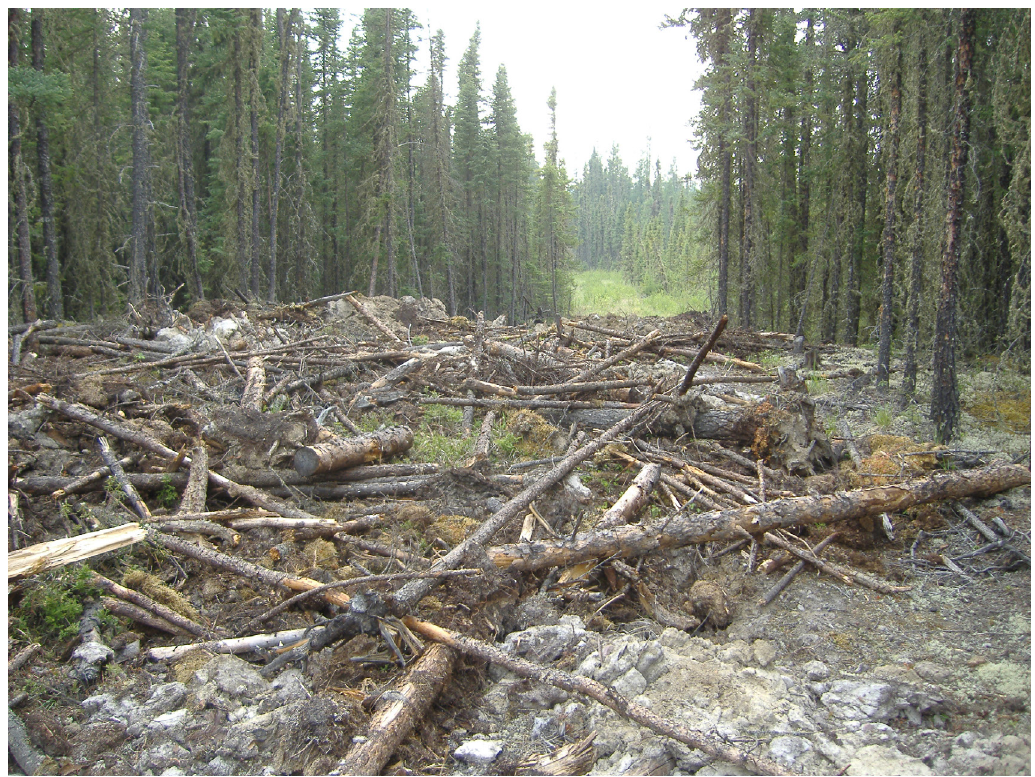
Figure 2. Use of coarse-woody debris on a 4 m wide seismic line. Photo courtesy of Canadian Natural Resources Ltd. Primrose and Wolf Lake